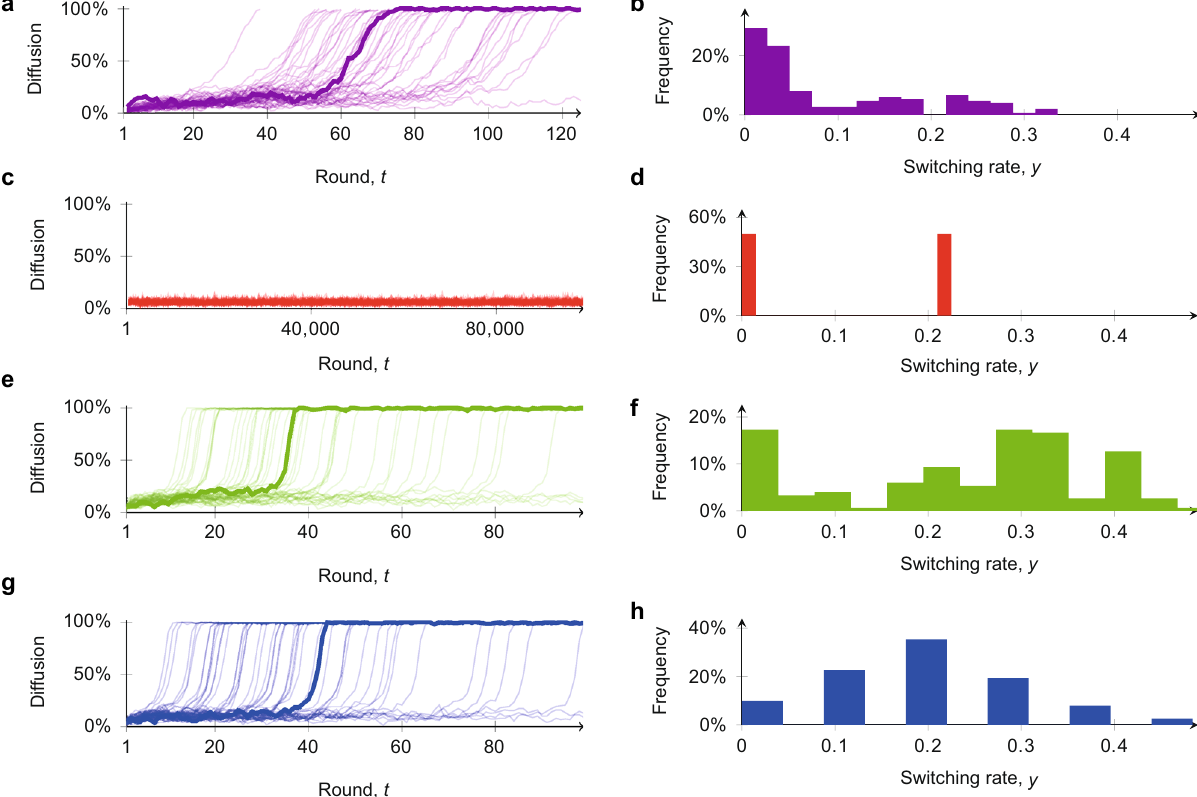
Fig. 3 Comparison of the proposed agent-based model with a standard coordination game model. In all fi gures, we set n = 200, 25% of committed minority, and we generate 50 independent simulation runs. One representative simulation is highlighted in each plot, with the corresponding switching rate in the right panel. a , b Simulations of our model with ρ e = 0.5. c , d Simulations of a pure coordination model calibrated from our empirical data ( β v = 4.8 for explorers and β v = 19.7 for non-explorers), with ρ e = 0.5. e , f Explosive delayed diffusion is obtained with a pure coordination game by increasing the fraction of explorers to ρ e = 0.7. g , h Explosive delayed diffusion is obtained with a pure coordination game by decreasing the rationality of non-explorers to β = v